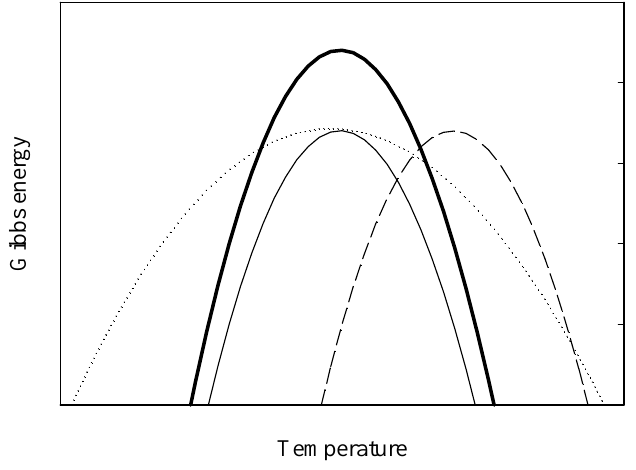
Figure 1. Stability profiles depicting the different ways to increase the denaturation ). The solid thin line represents the stability curve for a hypothetical temperature (T m protein from an organism growing in moderate temperature. Proteins from hyperthermophiles can adapt to higher temperature by (i) shifting the curve up (solid thick line), (ii) shifting the curve to the right (dashed line), and (iii) flattening the curve (dotted